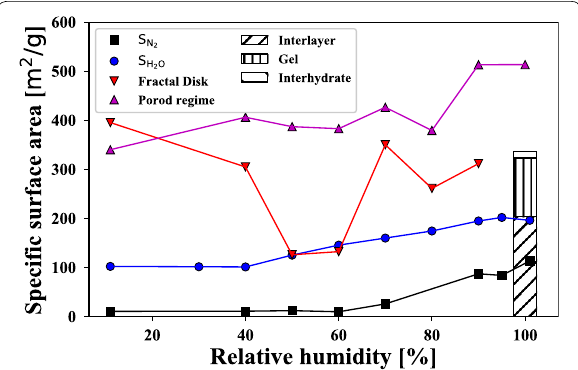
Fig. 12 Change of the surface area as a function of equilibrium relative humidity, obtained from different techniques: sorption isotherm data from Maruyama et al. (2014), SAXS data from Maruyama et al. (2017b), NMR data from Maruyama et al.